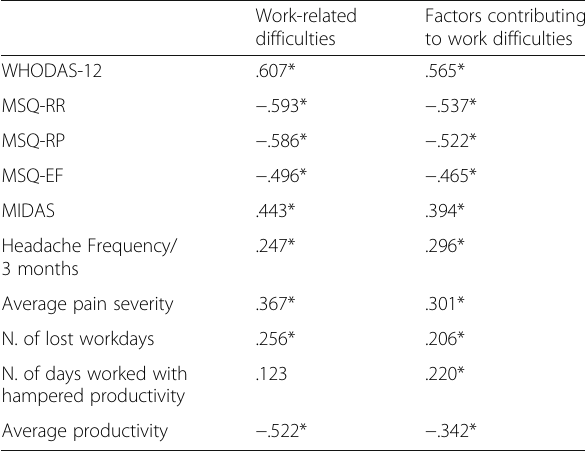
Table 3 Correlation analysis between HEADWORK scales, patient-reported outcomes, headache frequency, pain intensity and productivity indexes ( N =